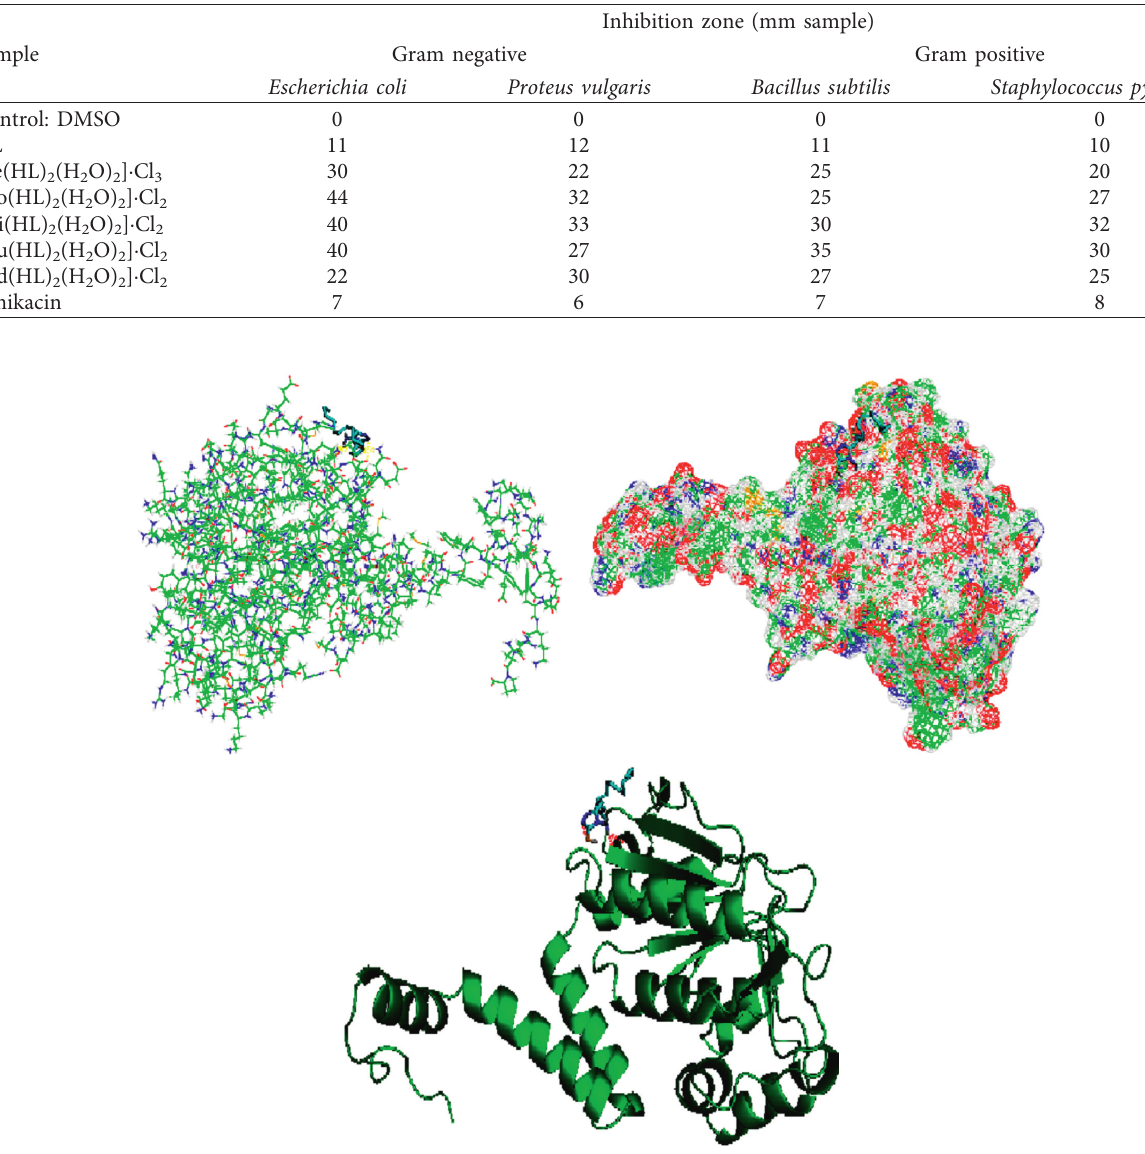
Table 3: Biological activity of triazole ligand and its metal chelates.